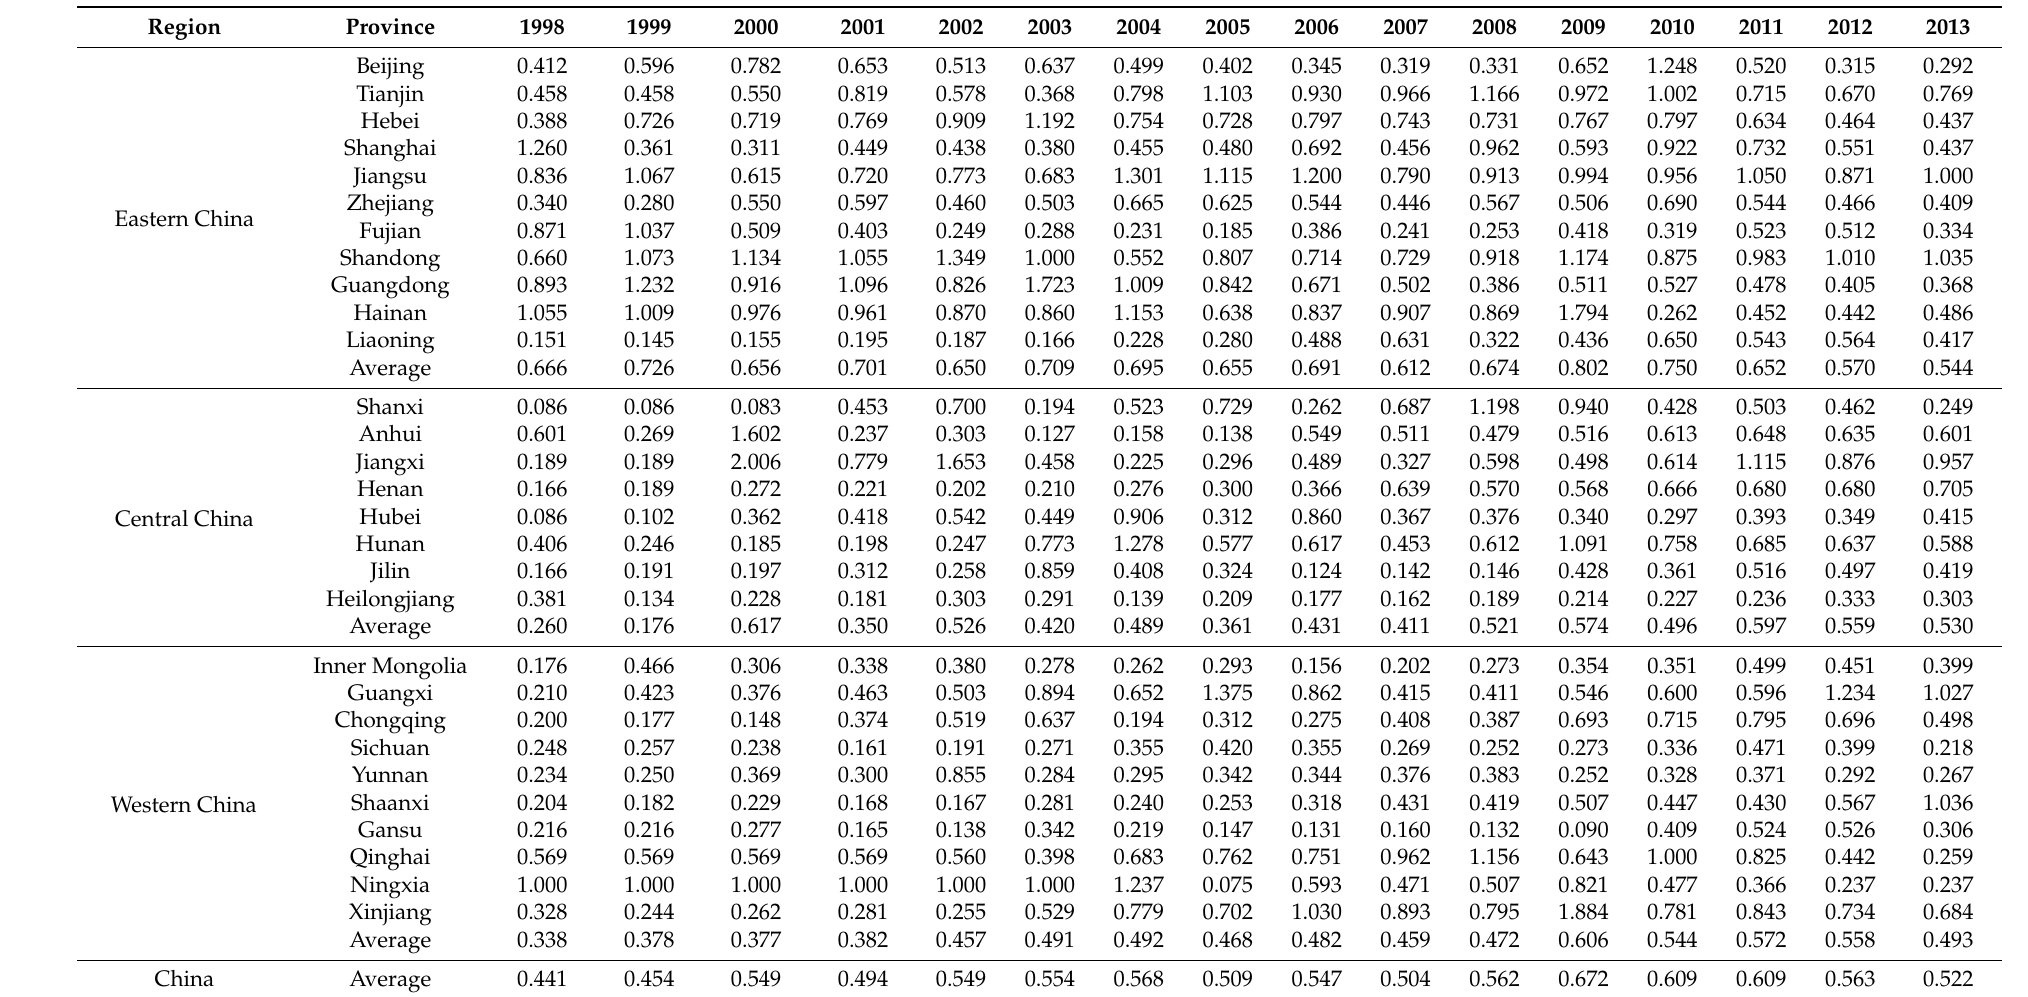
Table 2. NEI’s provincial technical efficiency from 1998 to 2013 in